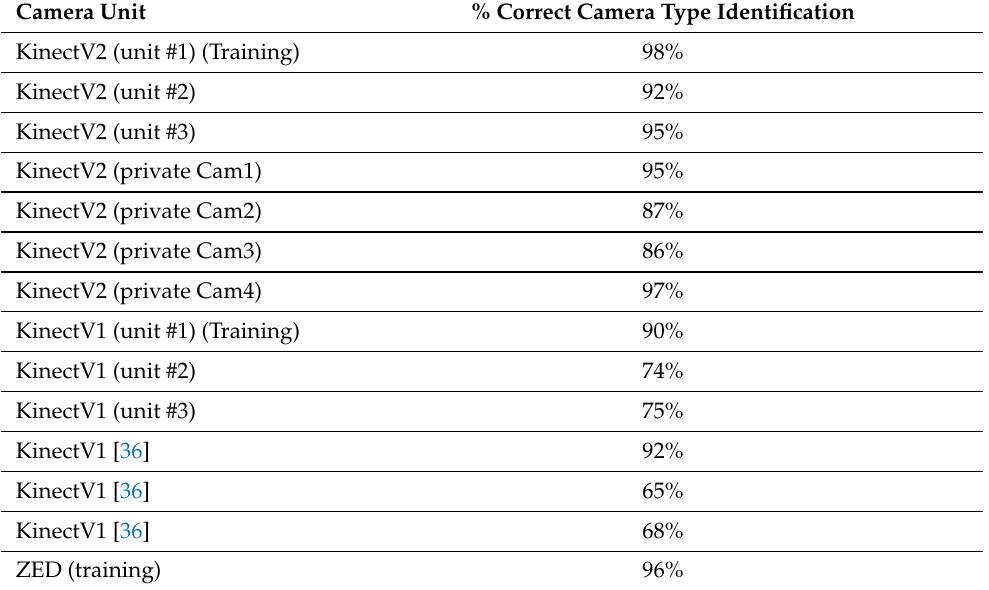
Table 2. Camera source identification